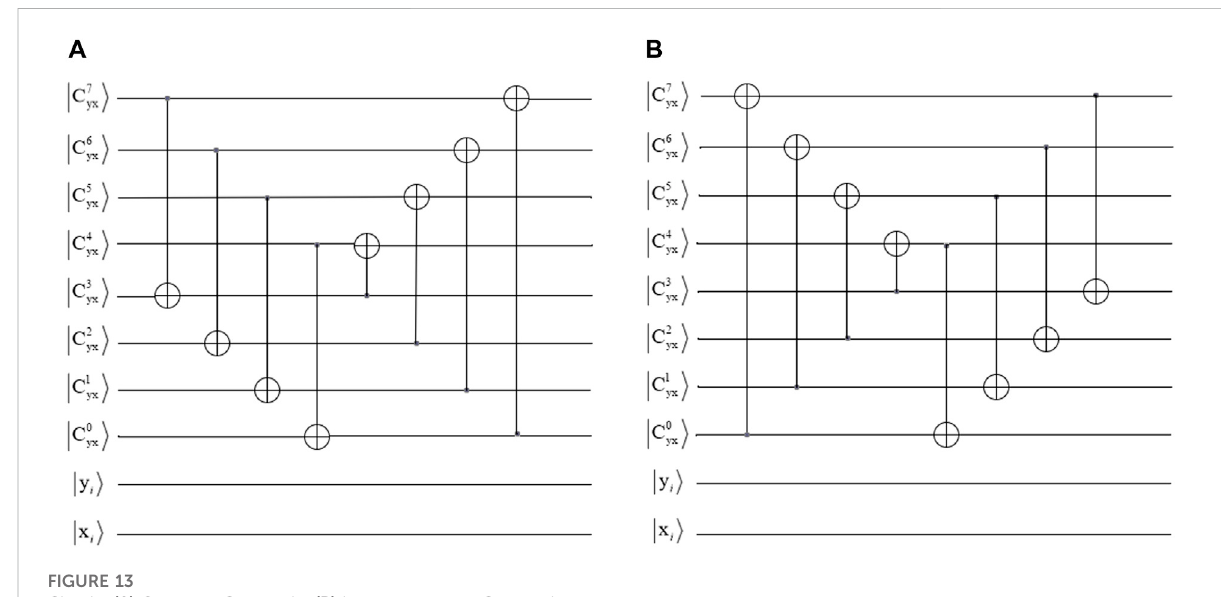
FIGURE 13 Circuits (A) Quantum Gray code, (B) Inverse quantum Gray